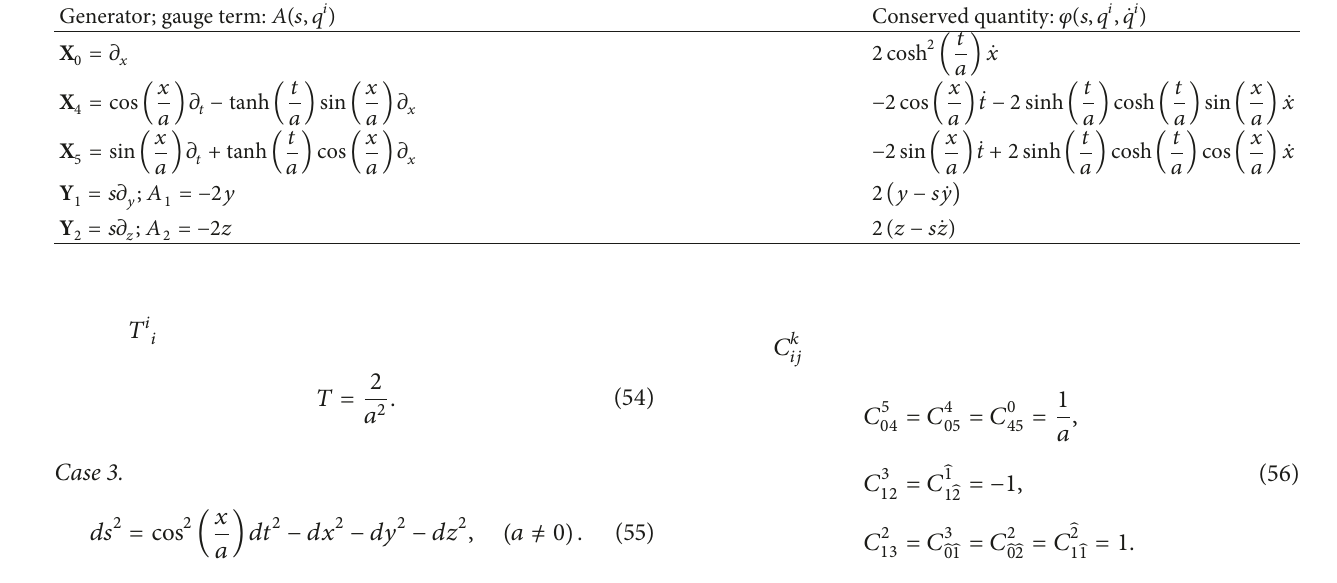
Table 11: Conserved quantities corresponding to each Noether